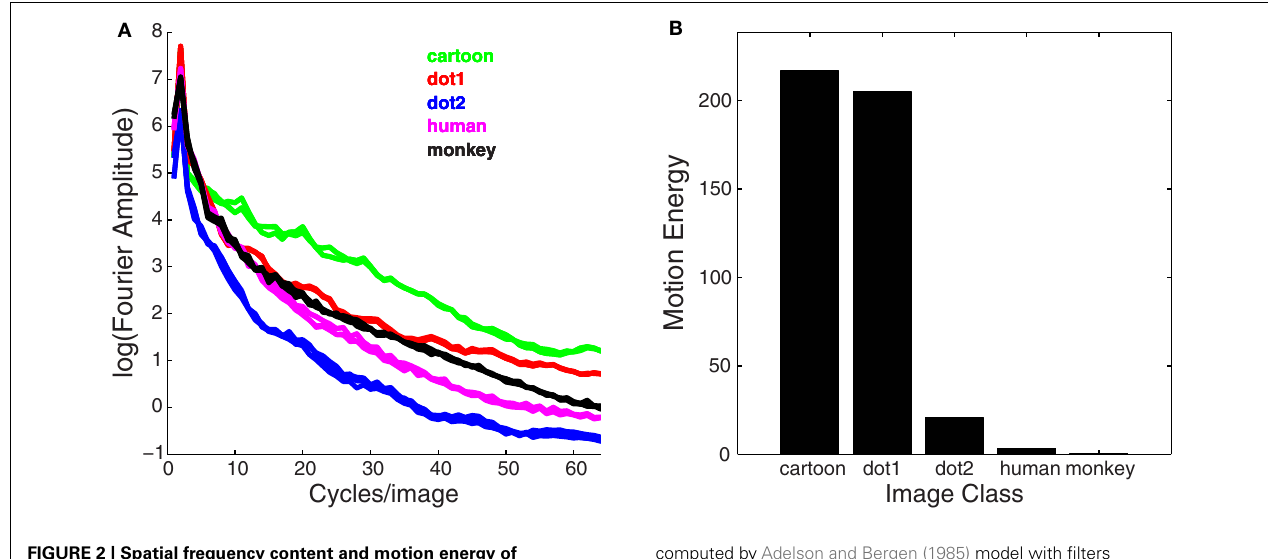
FIGURE 2 | Spatial frequency content and motion energy of stimulus images. (A) Fourier frequency spectrum averaged over all orientations for each stimulus category. (B) Motion energy